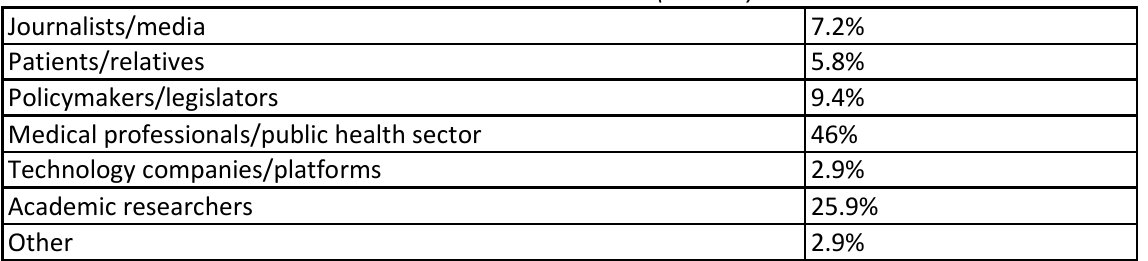
Table 3. Stakeholders (n =